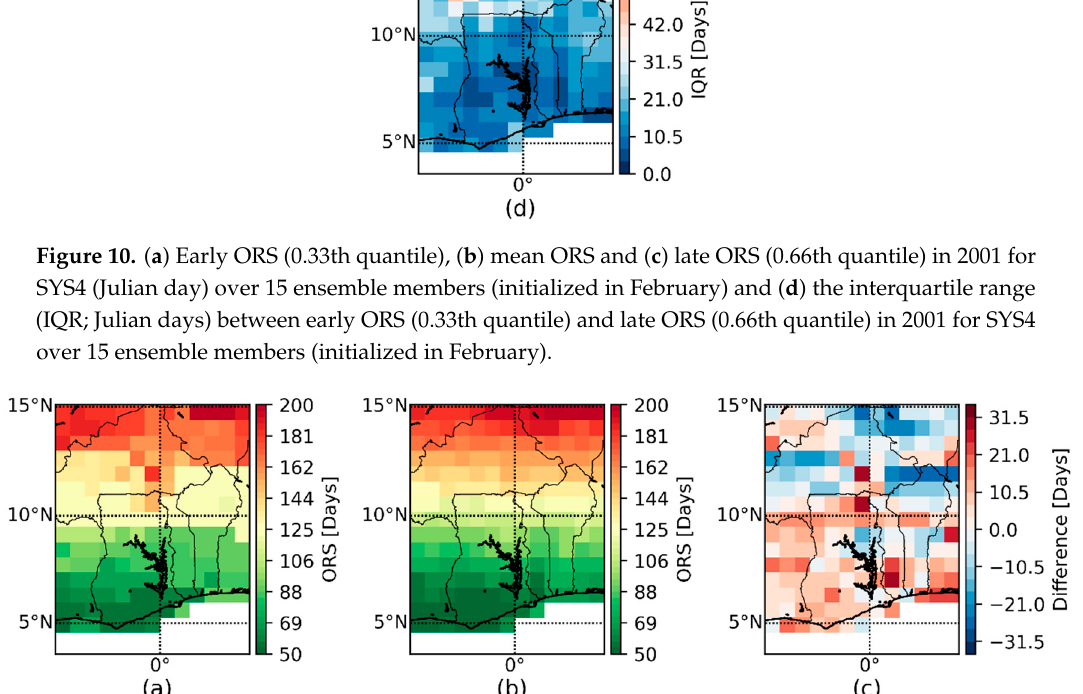
Figure 12. Relative frequency in percent (%) of the 15 ensemble members for the year 2001 of SYS4 by the classification into the categories: ( a ) “Below Average” ( 𝑝 (cid:2869) ), ( b ) “Near Average” ( 𝑝 (cid:2870) ) and ( c ) “Above Average” ( 𝑝 (cid:2871) ).